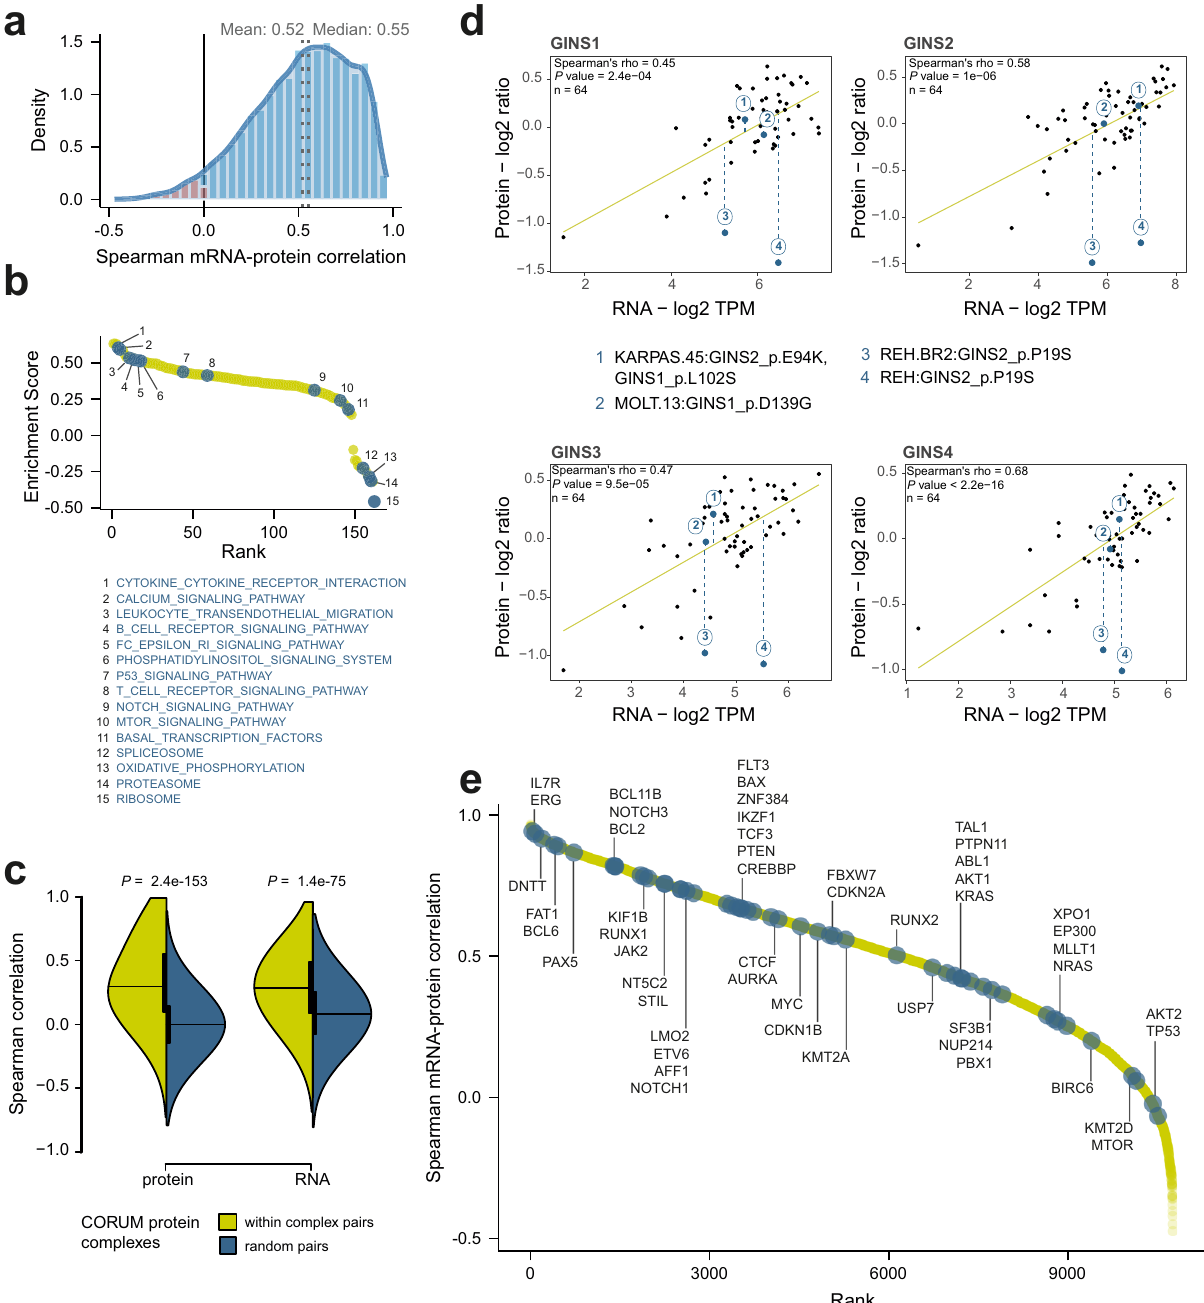
Fig. 2 Synergies and discordances of mRNA and protein levels in childhood ALL cell lines. a Density plot of Spearman rank order of gene symbol-wise correlation of the mRNA-protein levels ( n = 10,738 RNA-protein pairs), with RNA or protein markers strati fi ed by gene symbol. The mRNA-protein levels were positively correlated for 97% of the pairs across the entire matching panel ( n = 64 samples), with 78% of the pairs showing signi fi cant positive correlation (FDR ≤ 0.01) assessed by t-distribution adjusted P value. b GSEA of the mRNA-protein level correlations for KEGG pathways ( n = 162 ranked pathways) showing that certain specialized signal transduction pathways were enriched among the highly correlating pairs, while pathways associated with the spliceosome, proteasome, and ribosomes belonged to the lowest mRNA-protein correlating pairs. Selected pathways are annotated with blue circles . c Comparison of random pairwise correlations (blue) of quantitative proteomics data and mRNA levels across the 49 ALL cell lines and their replicates to known (yellow) interaction pairs ( n = 31,842) from the CORUM database demonstrating higher correlations at the protein level. The statistical difference was assessed using an unpaired two-sided t -test, with P values ( p ) indicated. The center line in the violin plots represents the median, the vertical bars represent the fi rst and third quartiles and the curve represents the density curve. d Relative log2 ratio protein levels versus log2 TPM (Transcripts Per Million) mRNA levels of Go-Ichi-Ni-San (GINS) complex members across 49 cell lines and their biological replicates. GINS mutations (amino acid substitution) for GINS-complex members are shown for annotated cell lines MOLT-13, KARPAS-45, and REH. Fitted lines were plotted using a linear fi t. Dotted lines represent the difference between the actual protein levels and the mRNA-predicted levels. Correlation P values are derived from two-sided t-distribution. e Ranked mRNA – protein correlations ( n = 10,738 ranked mRNA-protein pairs) with selected highlighted markers (blue circles) that are frequently involved in or associated with leukemogenesis. Source data are provided as a Source Data File